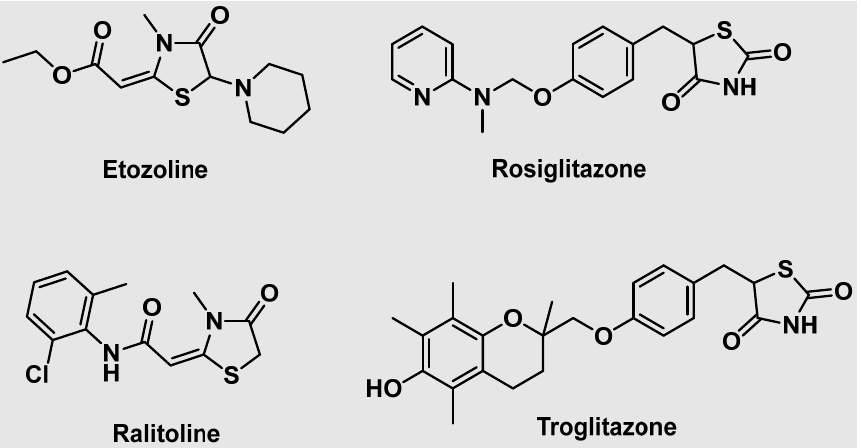
Molecules 2022 , 27 , x FOR PEER REVIEW Figure 1. Recently published thiazolidinones targeting breast cancer. Figure 1. Recently published thiazolidinones targeting breast cancer.